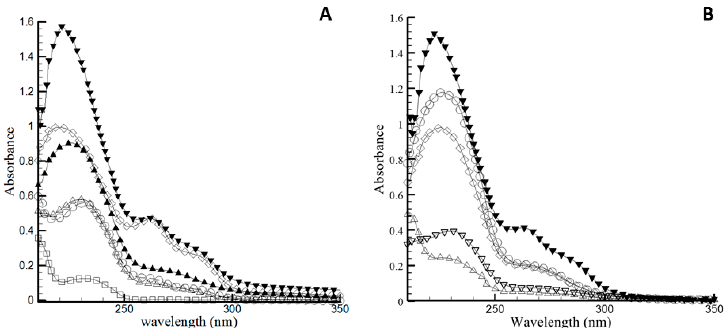
Figure 4. UV-visible absorption spectra of bullfrog oil exposed to the Schaal oven test at 60 °C. ( A ) Represents the spectra of pure bullfrog oil (BO): ( □ ) 0 day, ( ο ) 3 days, ( ∆ ) 6 days, ( ▲ ) 9 days, ( ◊ ) 12 days, ( ▼ ) 15 days. ( B ) corresponds to different BO samples containing antioxidants exposed to the Schaal oven test after 15 days: ( ▼ ) BO, ( ο ) BOAm, ( ◊ ) BOTm, ( ) BOAmx and ( ∆ ) BOTmx.